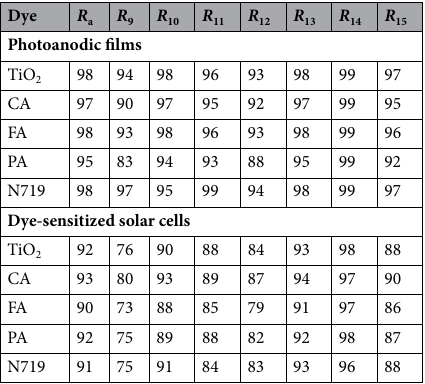
Table 5. The general CRI ( R a ) and the special CRIs ( R 9 – R 15 ) of the light transmitted through the TiO 2 -only, CA, FA, PA, and N719 photoanodic films and their dye-sensitized solar cells.